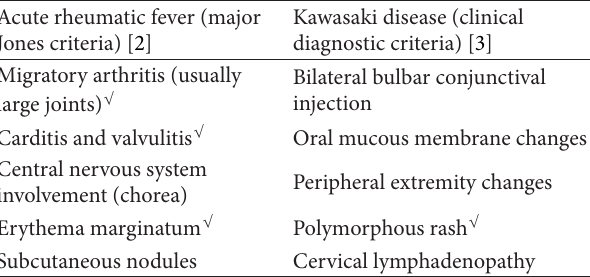
Table 1: Clinical manifestations of acute rheumatic fever versus Kawasaki disease found in the reported case (noted with √ symbol).